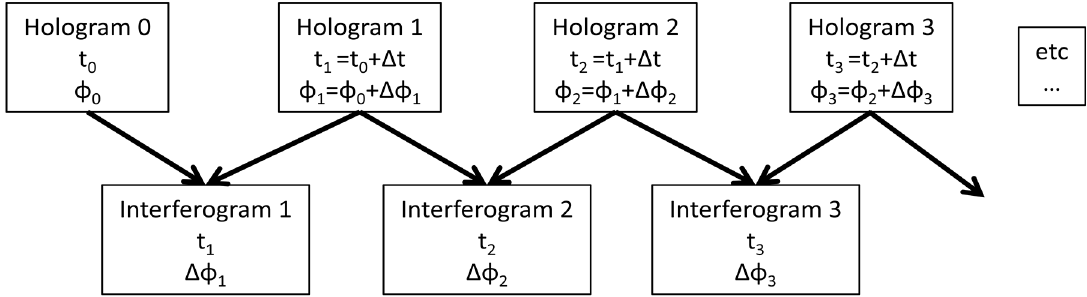
Figure 1. Scheme of interferogram generation from data collected from the climate chamber-Digital Holographic Speckle-Pattern Interferometry (DHSPI) workstation.